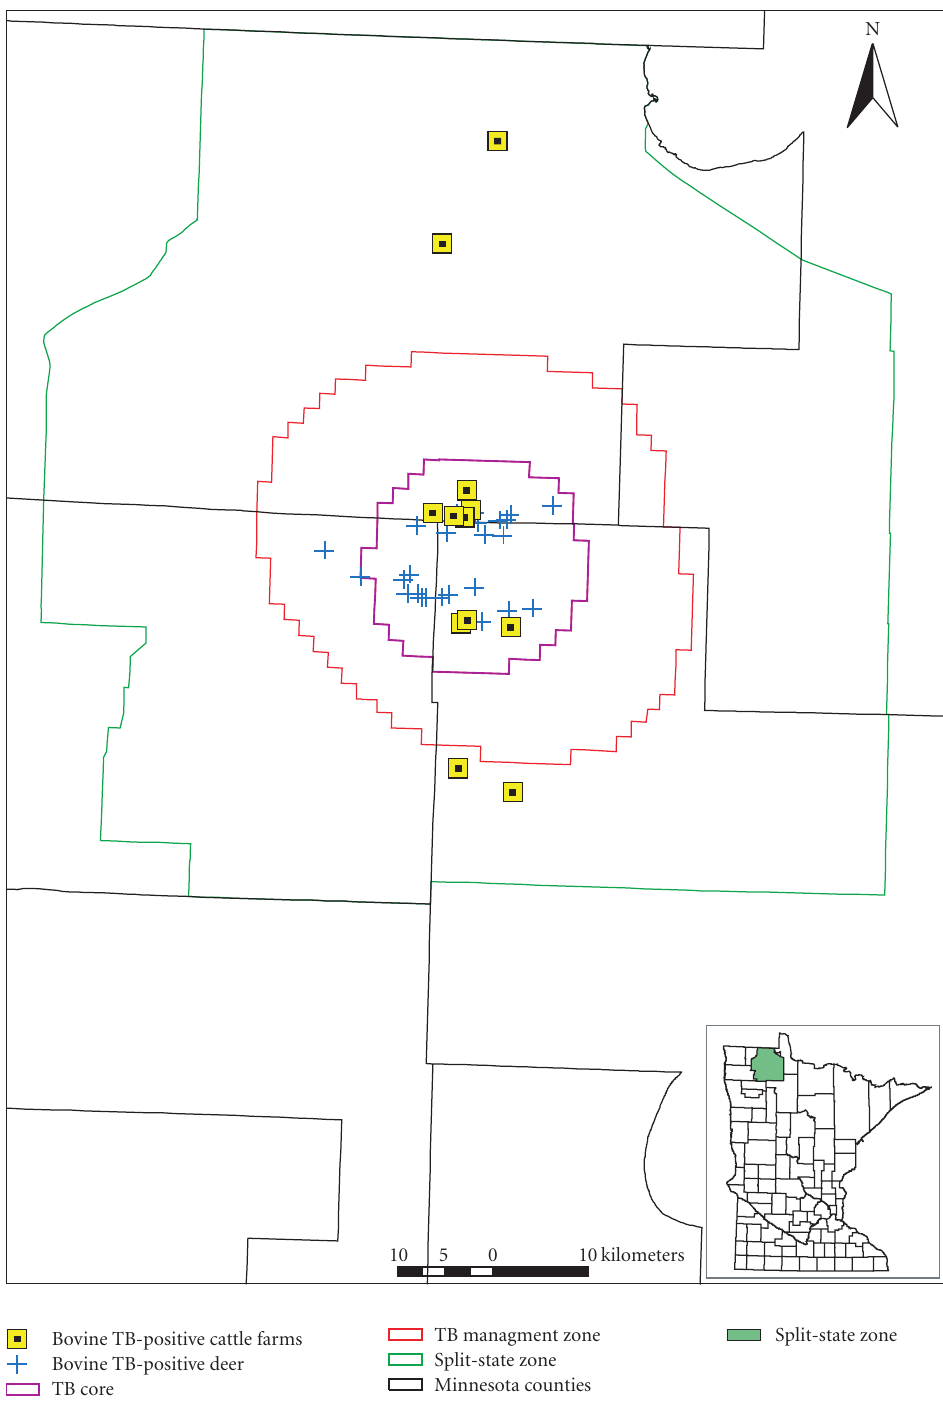
Figure 1: Spatial distribution of free-ranging white-tailed deer ( n = 27) and cattle farms ( n = 12) infected with bovine tuberculosis, 2005–2010, northwest